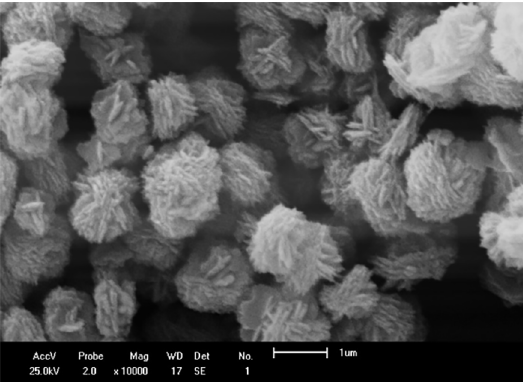
Figure 4. Image obtained by SEM for CuNH05 sample ZONH5 10.000 times.